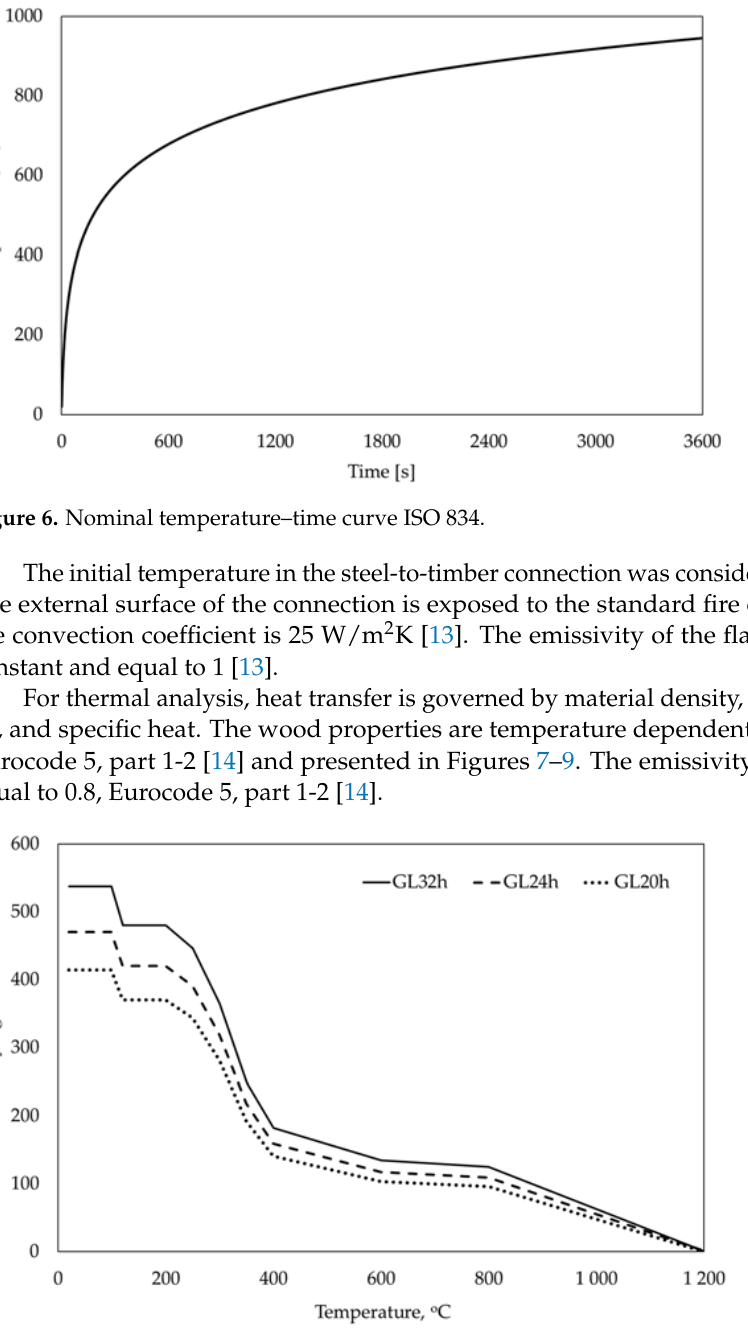
Figure 7. Density of wood.